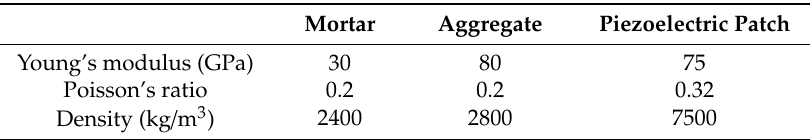
Table 1. Material